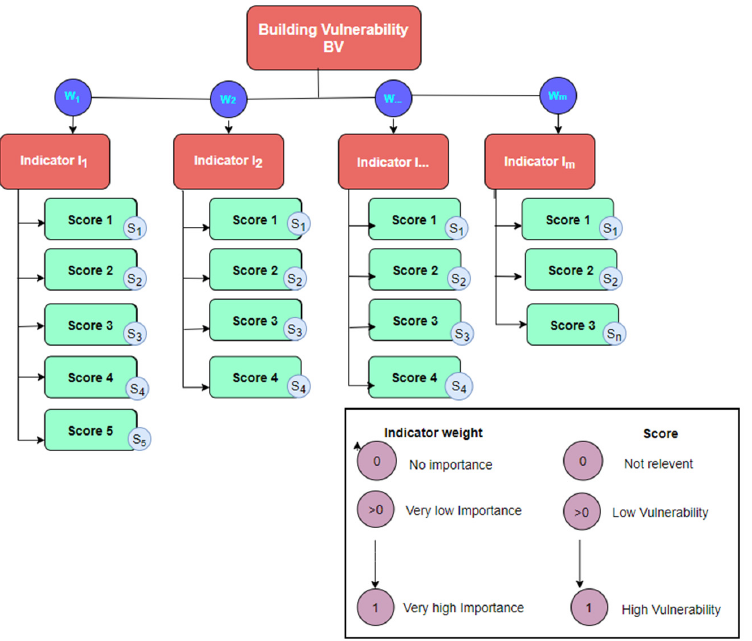
Figure 7. The conceptual methodology of the indicator ‐ based approach for the building [70].